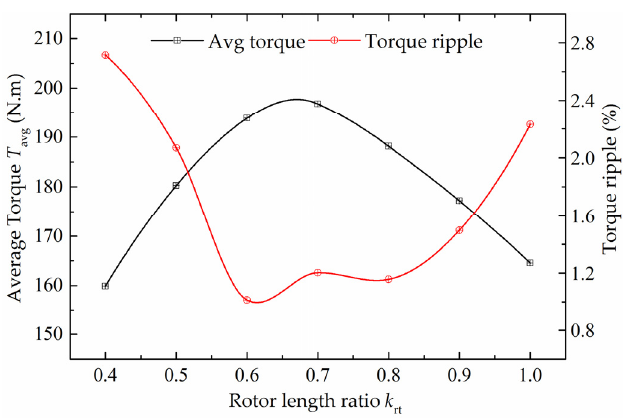
Figure 14. The influence of rotor teeth ratio k rt on average torque and torque